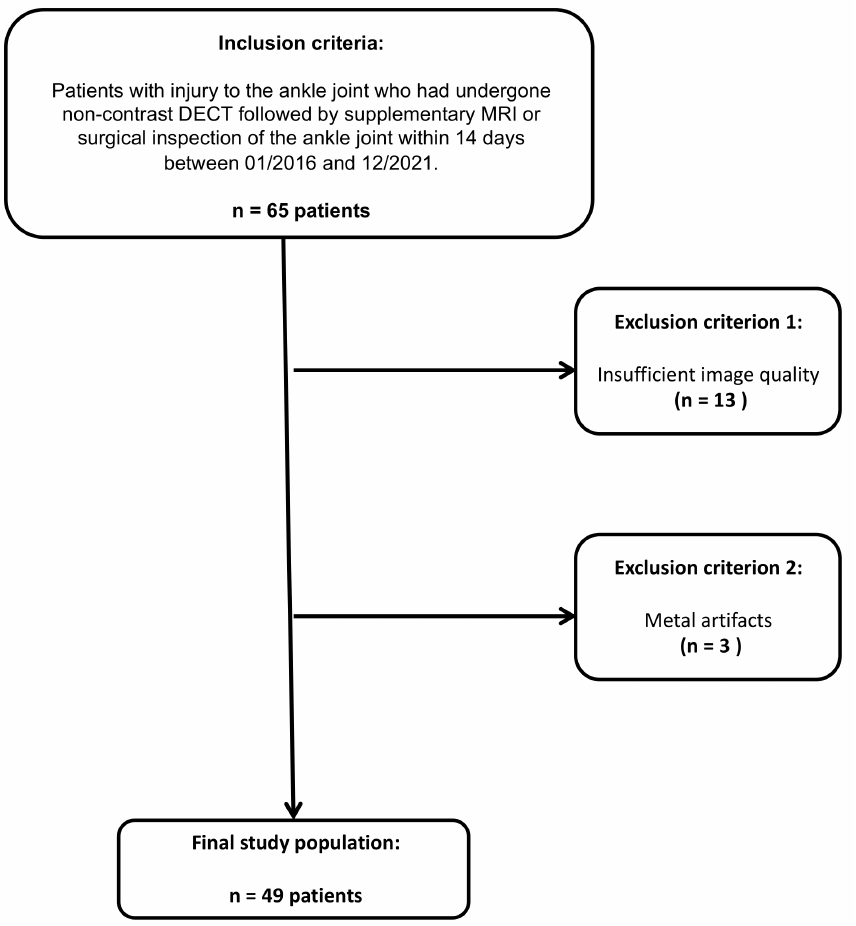
Figure 1. STARD (standards for the reporting of diagnostic accuracy studies) flow chart of patient